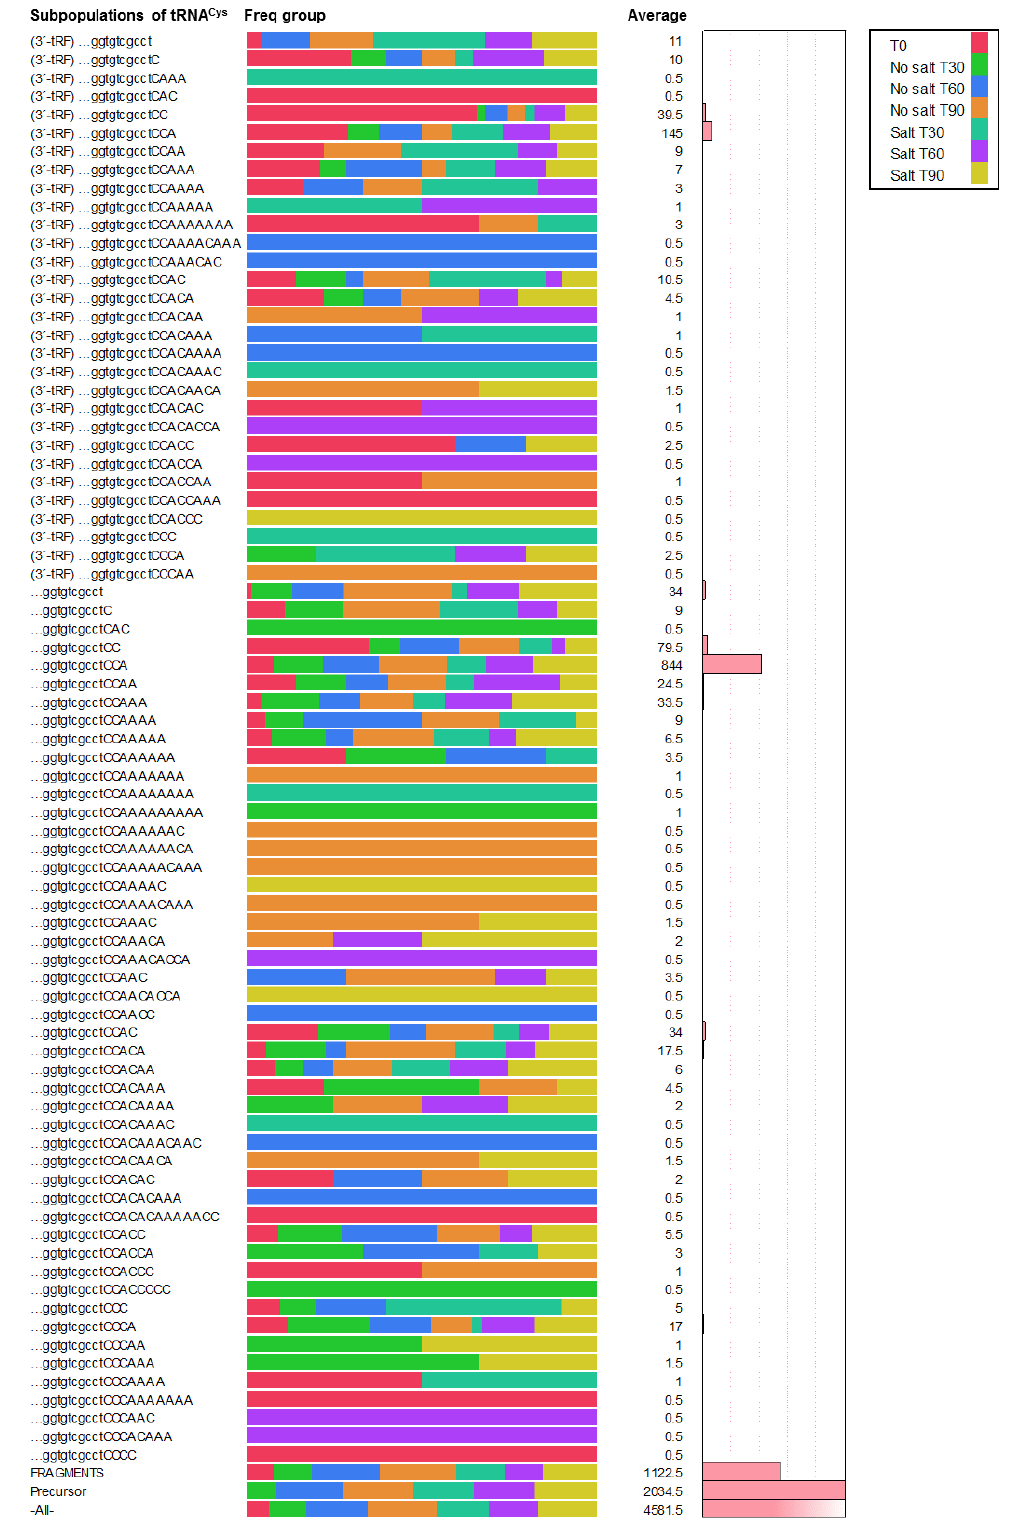
Figure 2. Distribution of subpopulations of tRNA Cys molecules in dormant spores (T0) and during the outgrowth process 30, 60 and 90 minutes after the initiation of germination in the absence and presence of 1.2 M of NaCl. We show the last ten nucleotides of tRNA Cys , with correct or incorrect additions at the 3´end. Fragments (total 5´-tRF and internal fragments), 3´tRF and precursors are indicated at the left side. The average of mapped reads for each subpopulation is indicated by a number and by the bar graph at the right side and its presence at each sampled time by a colored bar in the